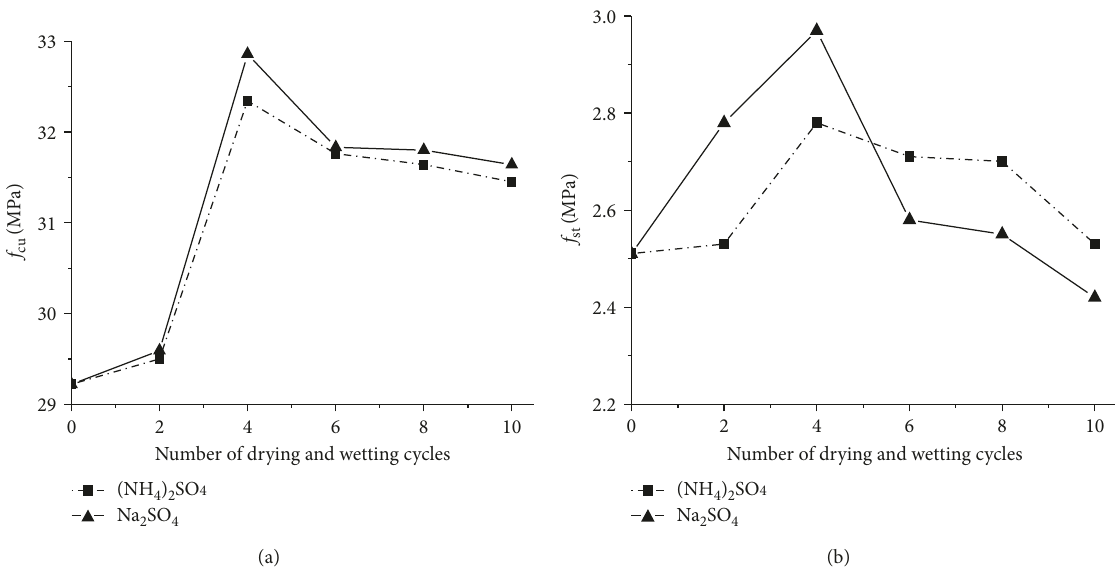
Figure 4: Changes in the strengths of corroded double-admixture concrete fly ash and polypropylene concrete varied to dry-wet cycles. (a) Compressive strength. (b) Splitting tensile